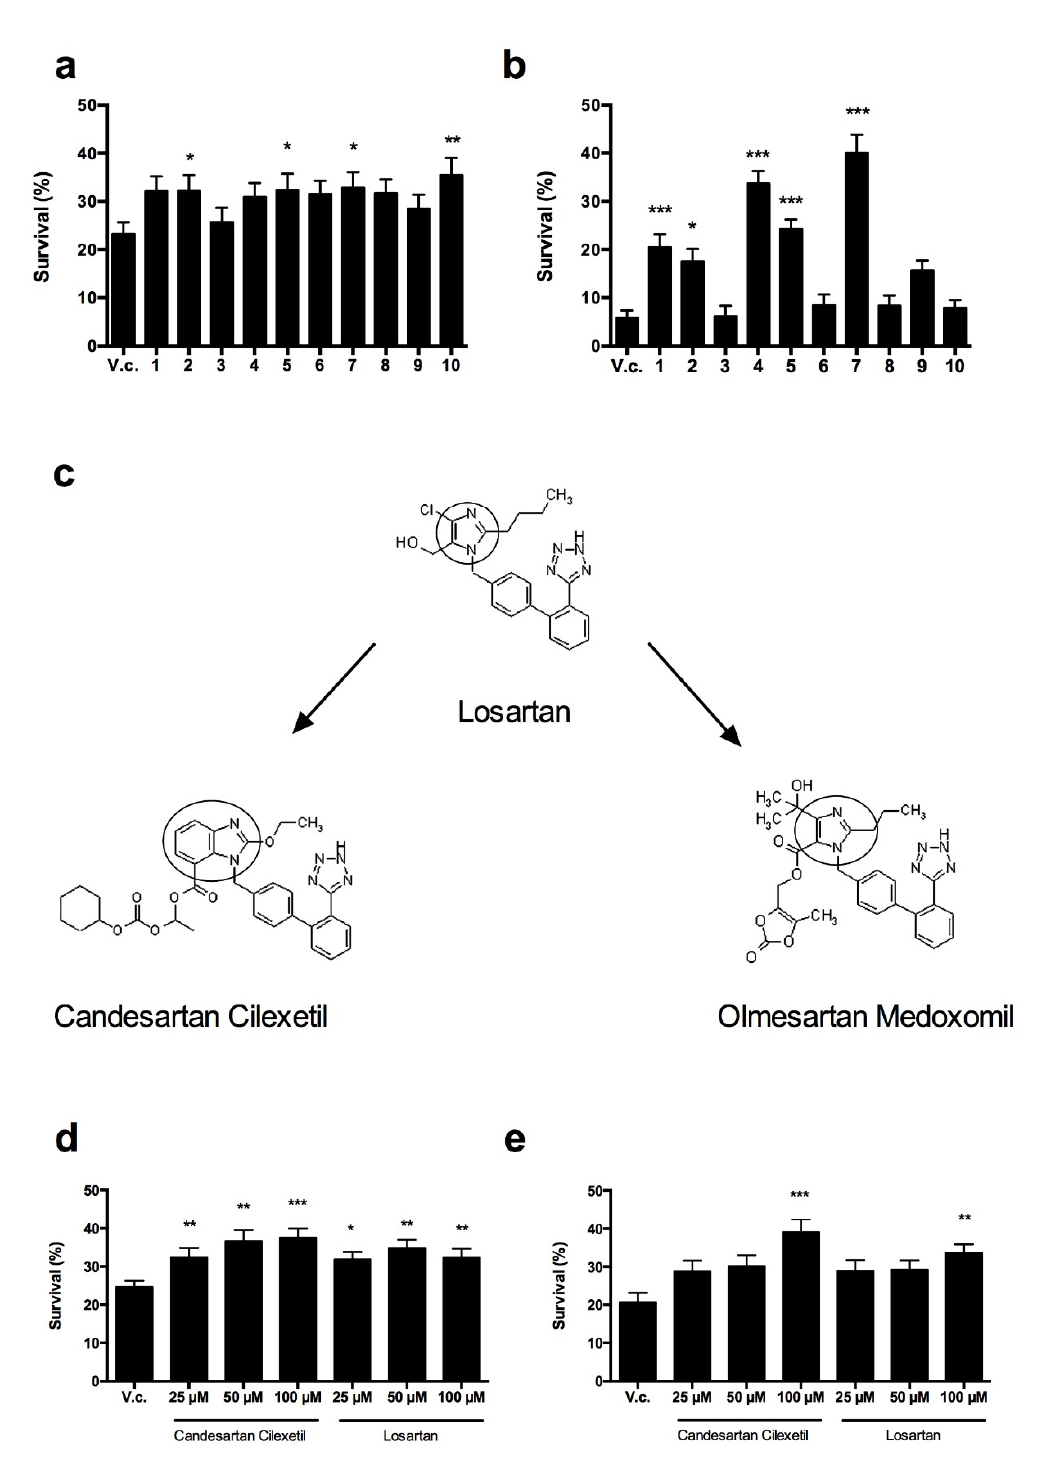
FIGURE 1: ARBs prevent Cu and Cp-induced killing of yeast cells. Yeast cells were incubated with 2 mM Cu for 4 h (a, d) or 250 µM Cp for 16 h (b, e) in presence of vehicle control (V.c, 2.5% DMSO) or 100 µM Candesartan (1), Candesartan Cilexetil (2), Eprosartan (3), Irbesartan (4), Losartan (5), Olmesartan (6), Olmesartan Medoxomil (7), Telmisartan (8), Trityl Candesartan Cilexetil (9) or Valsartan (10). (c) Chemical structure of the prototype Losartan, of which Candesartan Cilexetil and Olmesartan Medoxomil are derived . The benzimidazole group in Candesartan Cilexetil and the imidazole ring in Losartan and Olmesartan Medoxomil are circled. Taken and adapted from [44]. Yeast sur- vival in presence of different doses of Candesartan Cilexetil or Losartan upon treatment with 2 mM Cu (d) or 250 µM Cp (e) . Survival was calculated by determining CFU/ml as compared to untreated control cells (no Cu or Cp). Experiment performed in quadruplicate, with at least two biological repeats. (*P < 0.05; **P < 0.01; ***P < 0.001; ANOVA test using Tukey